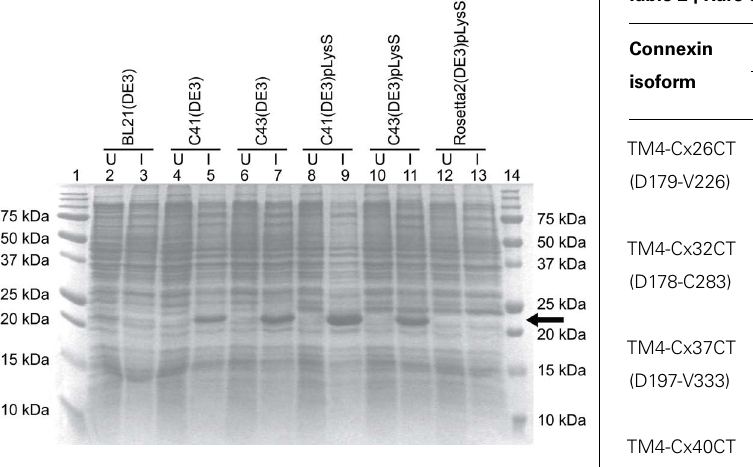
FIGURE 2 |TM4-Cx45CT expression profile obtained from different E. coli (DE3) strains with and without the pLysS plasmid in LB medium. TM4-Cx45CT was expressed in the following E. coli cell strains: BL21(DE3) (lanes 2 and 3), C41(DE3) (lanes 4 and 5), C43(DE3) (lanes 6 and